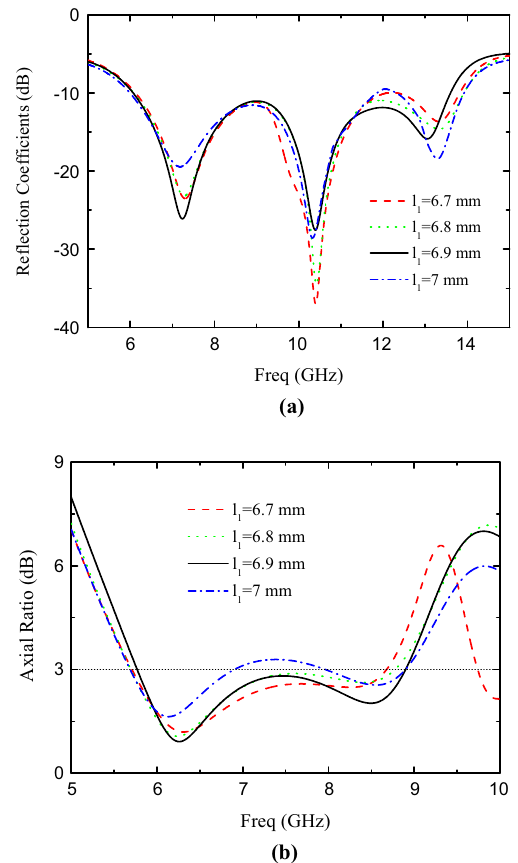
Fig. 6 Effects of different l 1 on the performance of the proposed antenna. a Reflection coefficients. b